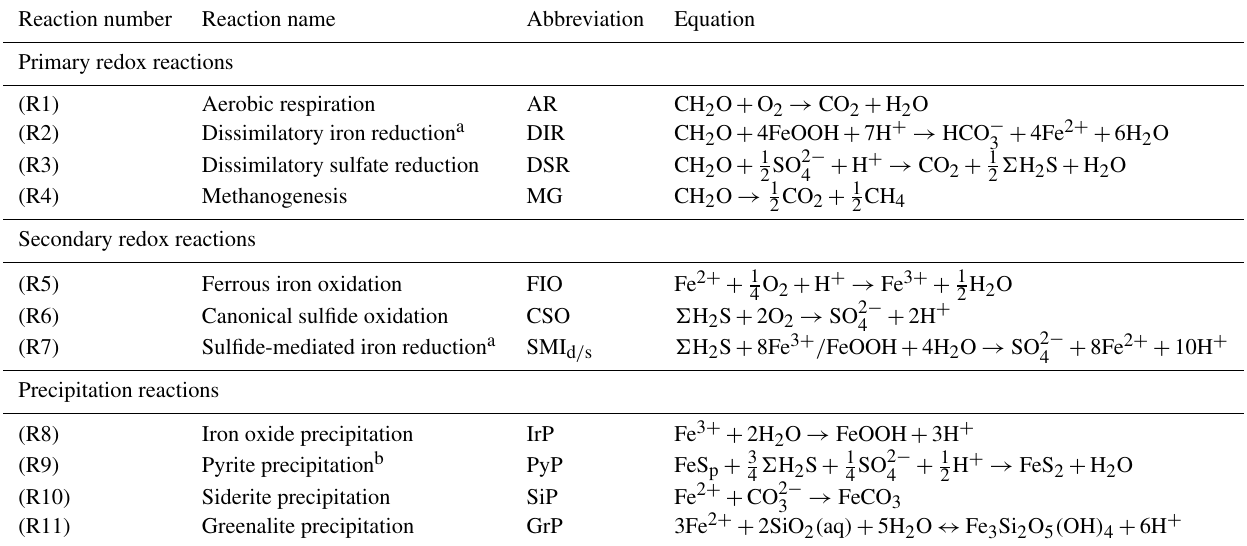
Table 1. List of biogeochemical reactions included in the reduced Fe–S scheme within the cGENIE model. A distinction is made between mineralization (“primary redox reactions”), re-oxidation of reduced products (“secondary redox reactions”), and precipitation reactions. The associated kinetic expressions are listed in Table 2. Note that we do not include any details for reactions involving the methane cycle here, though they are included in the simulations described here. For more information about the parameterization and reactions of the methane cycle in cGENIE, we refer the reader to Reinhard et al.